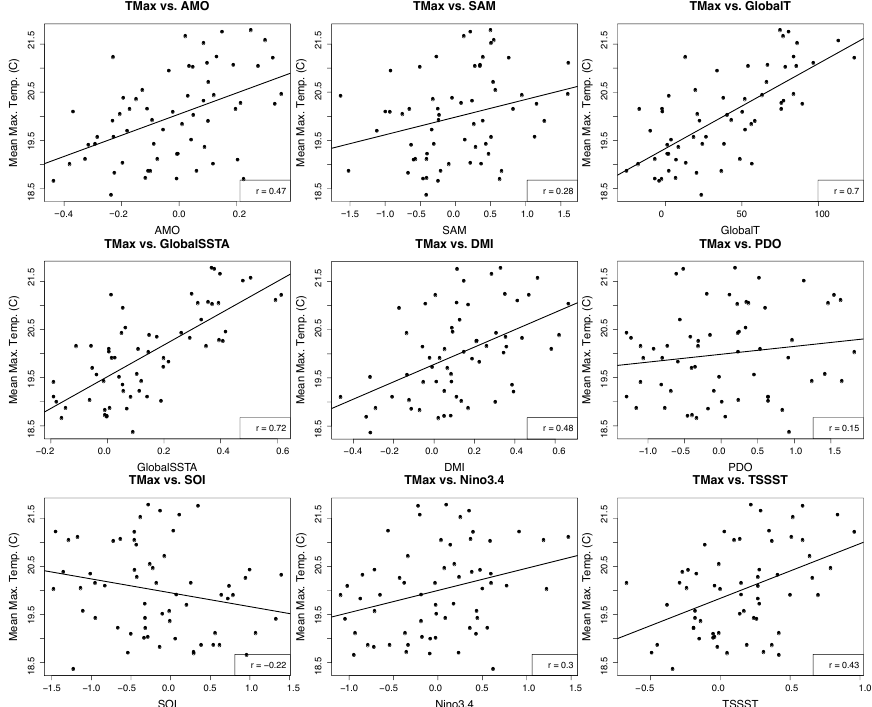
Figure 2. As in Figure 1 except for TMax. Predictors with | r | > 0.4 indicate moderate or strong relationships with TMax likely because they are attributes of global warming, or have been influenced by global